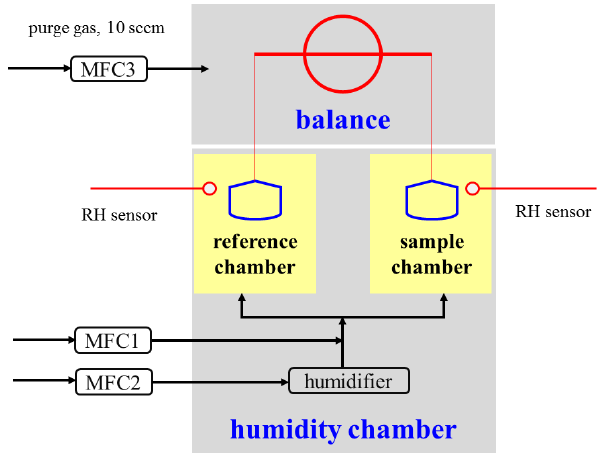
Figure 4. Schematic diagram of a vapor sorption analyzer (Q5000SA, TA Instruments, New Castle, DE, USA). Three mass flow controllers were used (MFC1: the dry flow; MFC2: the humid- ified flow; MFC3: the dry flow to purge the balance). Reprint with permission by Gu et al. (2017b).